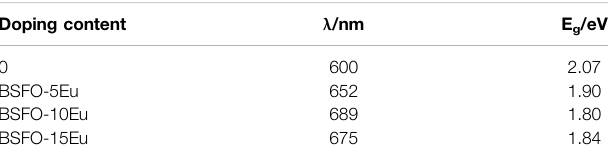
TABLE 1 | The band gap width of BSFEO.